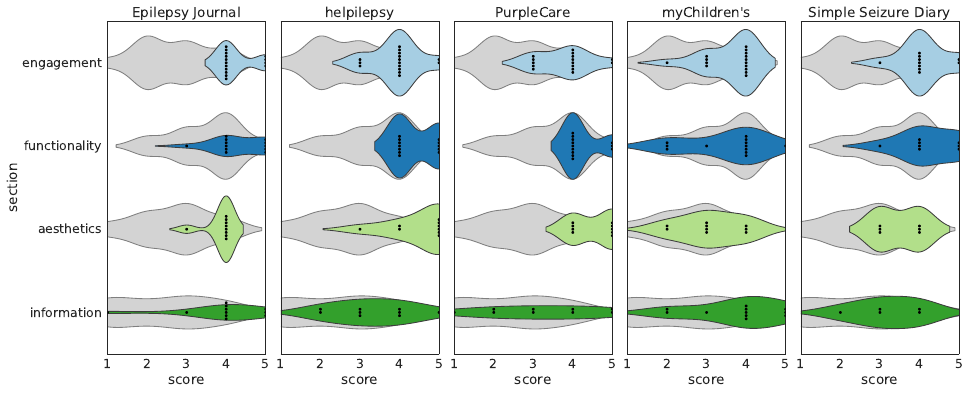
Figure 6. Section scores for top 5 Android